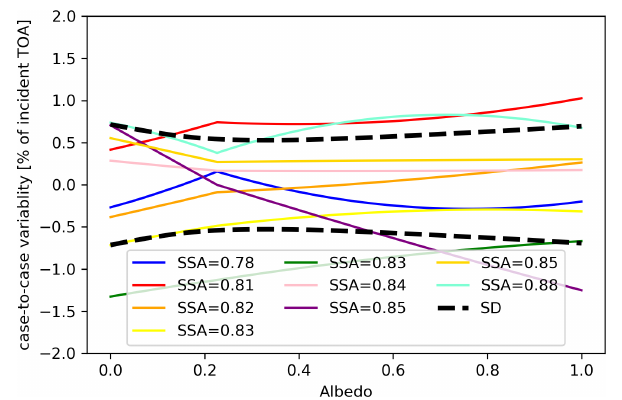
Figure 10. DARE as predicted by PX DARE for the nine cases (solid lines) and DARE as calculated by the RTM (dotted colored